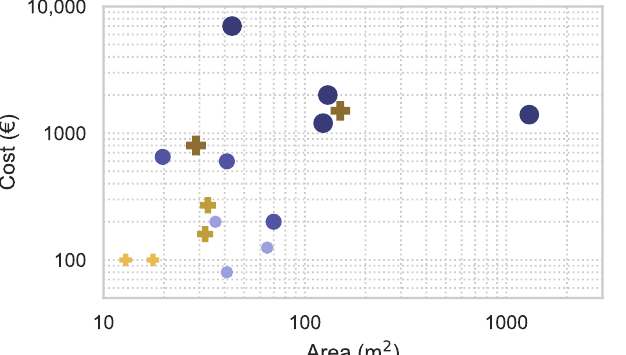
Figure 19. Readiness level of the analyzed papers.